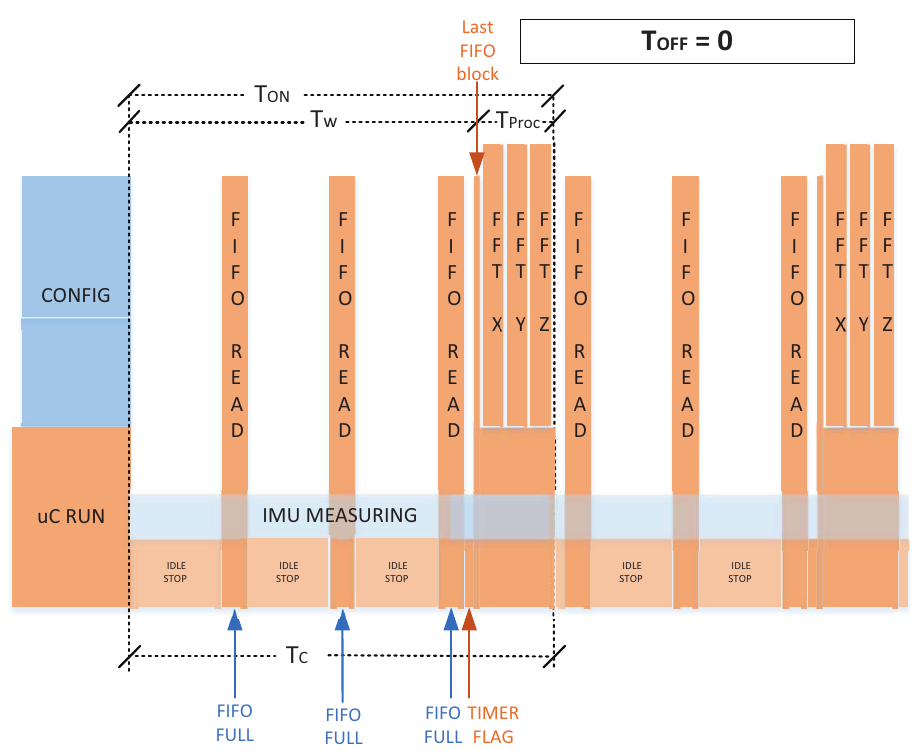
Figure 10. Power profile when T OFF =